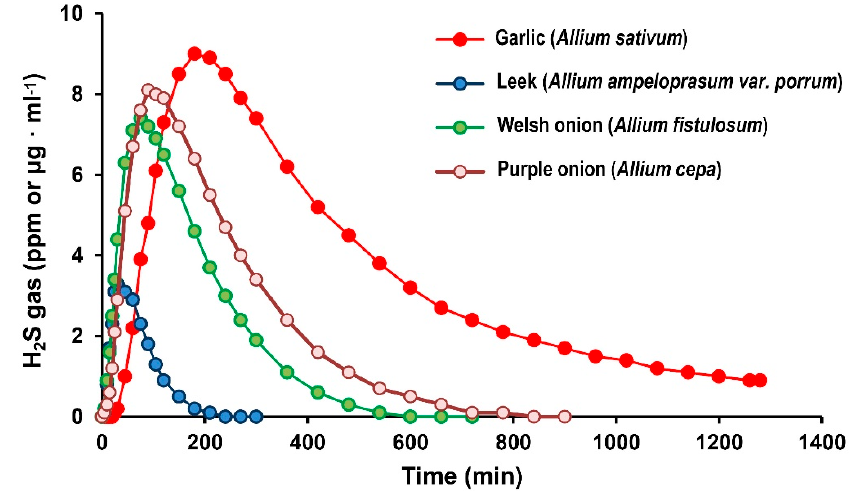
Figure 2. H S gas emission in different plant species including garlic ( Allium sativum L.) cloves, leek ( Allium ampeloprasum var. porrum), Welsh onion ( Allium fistulosum ), and purple onion ( Allium cepa ). H 2 S emission was recorded using an H 2 S sensor gas analyzer portable device. For each plant, 300 g of fresh material was used.